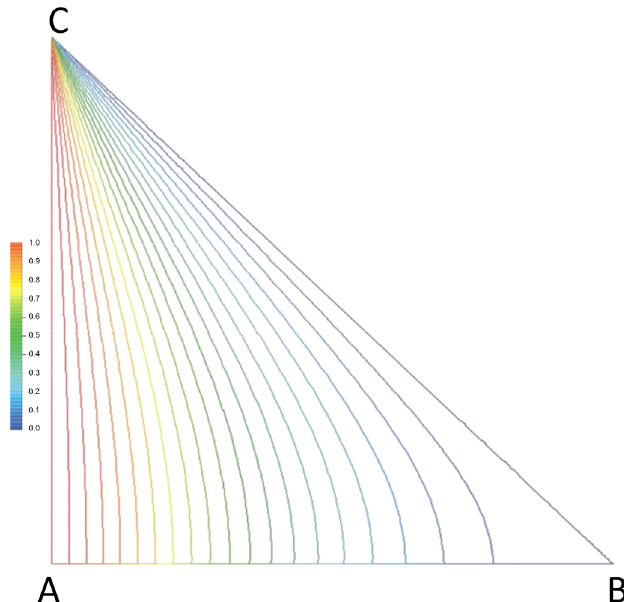
Fig. 8. Temperature contour of the triangular cavity with boundary condition on the walls, AB, ∂ u ∂ Pr = 0.71, Ra = 10 3 .